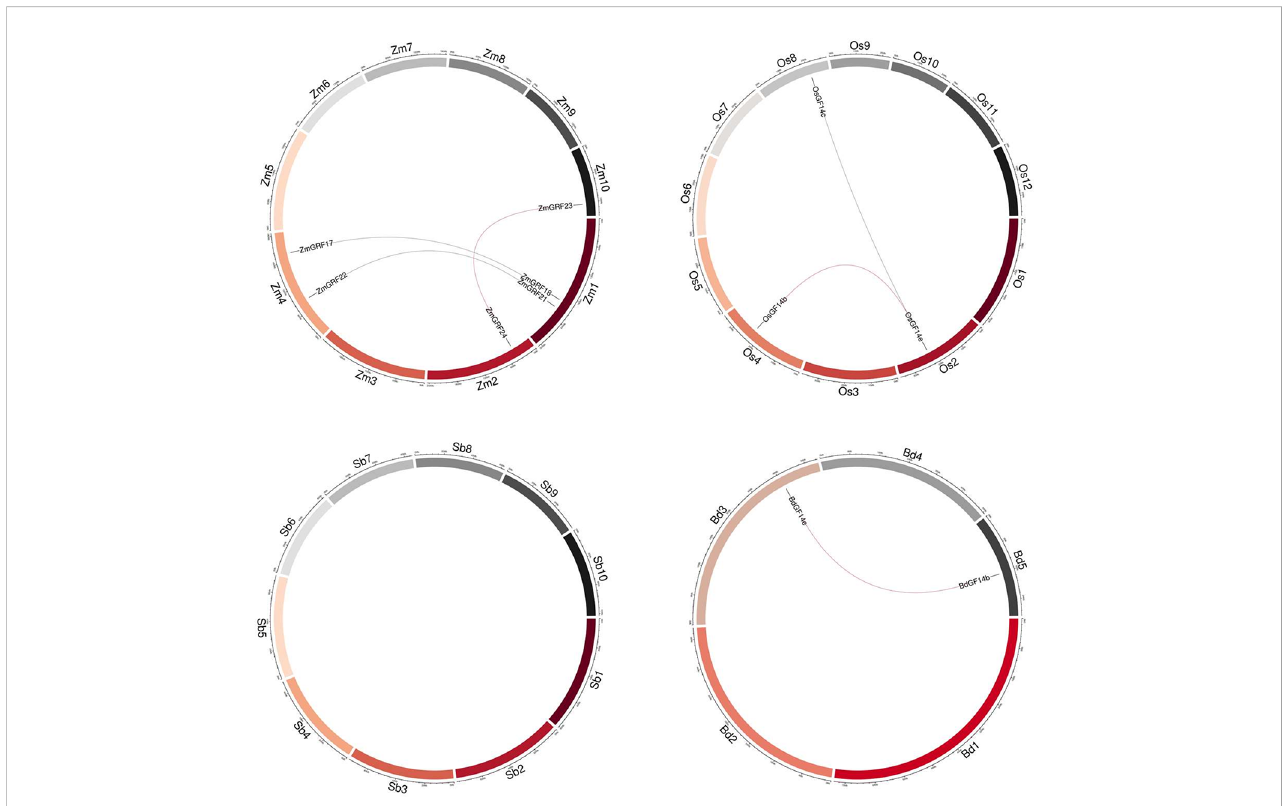
FIGURE 3 Synteny of four plants 14-3-3 genes. Zm1 – 10 represented maize chromosome 1 – 10, Sb1 – 10 represented sorghum chromosome, Bd1 – 5 represented brachypodium chromosome and Os1 – 12 represented rice chromosome, all chromosome indicated by colored boxes. Chromosome box numbers represent sequence lengths in megabases. All the syntenic genes were located in the